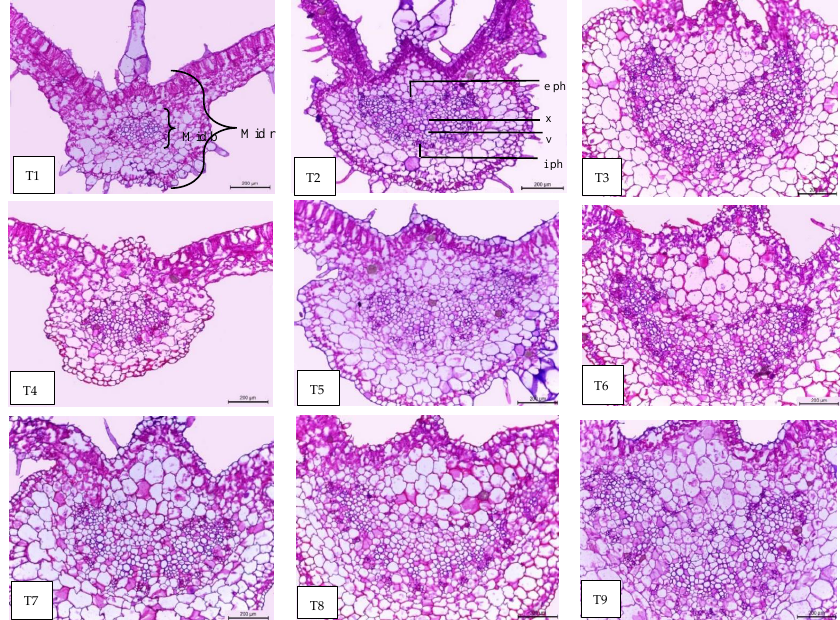
Figure 8. Magnified portions of the leaf blade midvein of tomato plants, aged 60 days. Scale bars = 200 µm. T1 — self-grafted Peto 86 as a control; T2 — Peto 86/ S. cheesmaniae; T3 — Peto 86/GS hybrid; T4 — Peto 86/Peto 86 + SA; T5 — Peto 86/ S. cheesmaniae + SA; T6 — Peto 86/GS hybrid + SA; T7 — Peto 86/Peto 86 + S. griseus ; T8 — Peto 86/ S. cheesmaniae + S. griseus; T9 — Peto 86/GS hybrid + S. griseus. Details: mid b, midvein bundle; mid r, midvein region; e ph, external phloem; i ph, internal phloem; v, vessel; x, xylem. Plants 2022 , 11 , x FOR PEER REVIEW